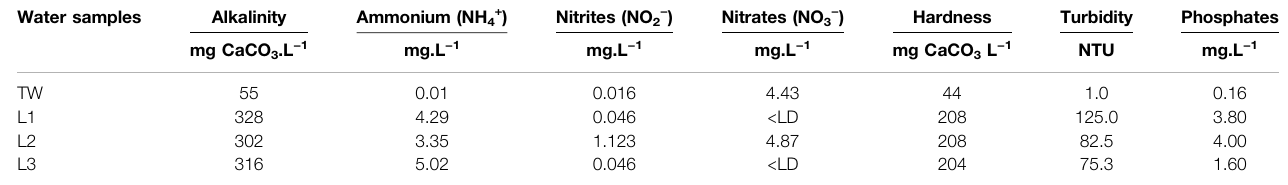
TABLE2| Physicochemicalparametersmeasured,inthelaboratory,intapwater(TW)andwaterfromsitesL1,L2,andL3,LuganoLake,BuenosAires.LD:limitofdetection. Water samples